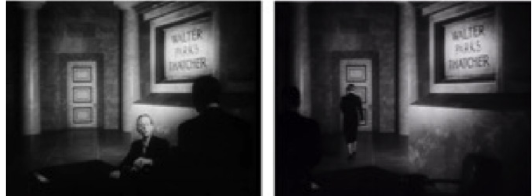
Figure 7: Added reverberation on voice and footsteps to create the perception of a big Marble Hall in Citizen